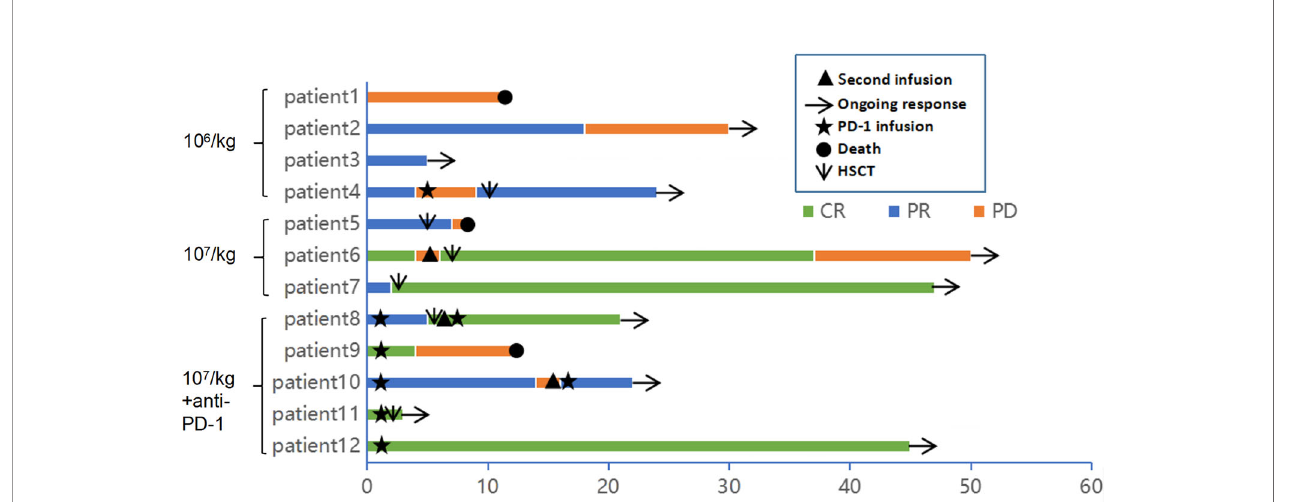
FIGURE 2 | Clinical response and duration for patients after anti-CD30 CAR-T cell infusion. The color and the length of each bar indicate the response to the anti- CD30 CART treatment and the duration of response, respectively. CR, complete remission; PR, partial remission; PD, progressive disease. The black triangle indicates the start time of the second cycle of CAR-T cell infusion. The arrow indicates a sustained response. The star indicates the start time of anti-PD-1 antibody therapy. The original point and the downward pointing arrow represent the death and the start time of hematopoietic stem cell